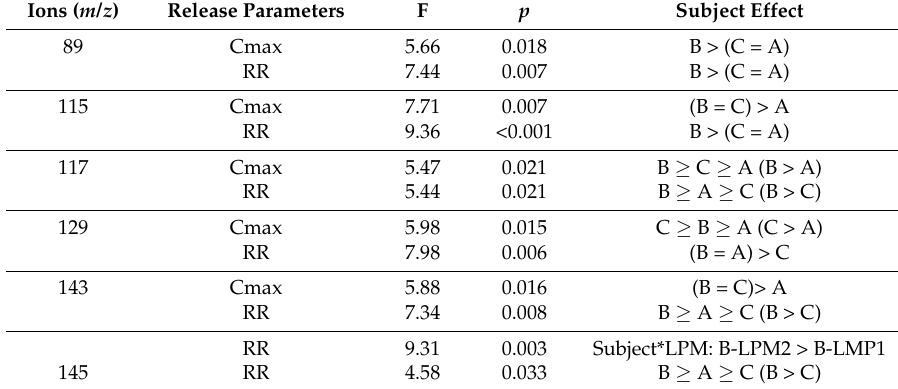
Table 3. In vivo aroma compound release. Fisher statistics from Analyses of Variance (ANOVA) of the temporal aroma compound release parameters. Only significant results ( p < 0.05) are reported.